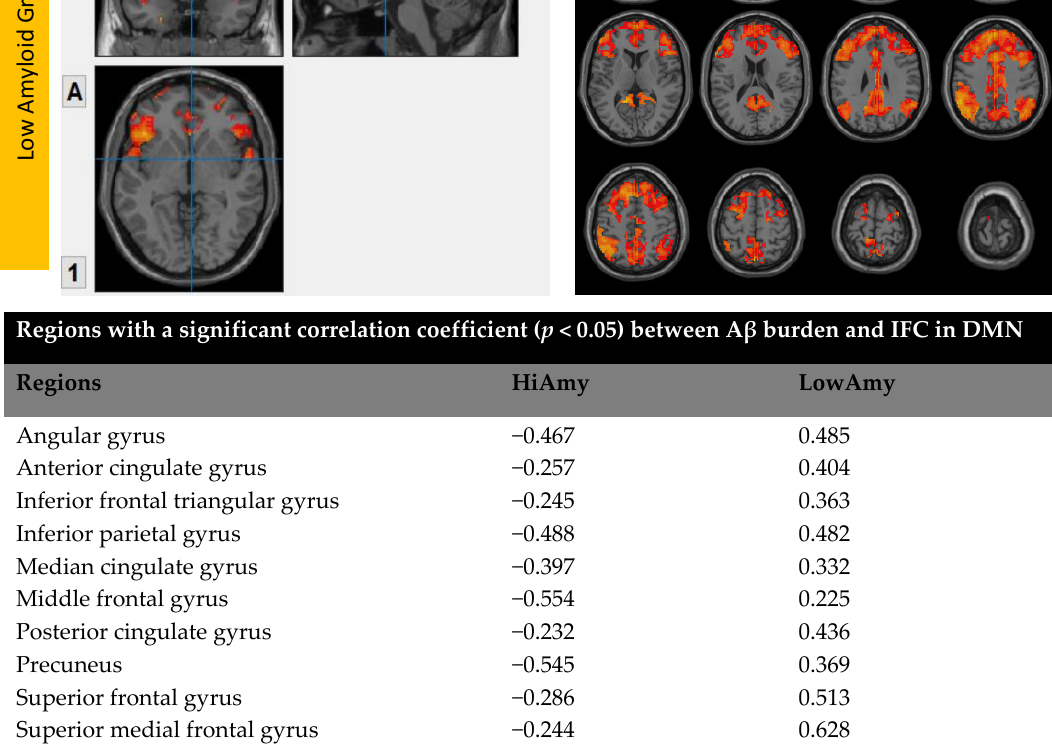
8 of 20 Figure 2. VMHC Maps showing interhemispheric functional connectivity (IFC) of HiAmy and LowAmy groups when compared to HC. ( a) showed Voxel-wise two-sample t-tests of VMHC maps from HiAmy when compared to HC. ( b) showed Voxel-wise two-sample t-tests of VMHC maps from LowAmy when compared to HC. All comparisons were adjusted for age, sex, and total intra- cranial volume, with Gaussian random field correction. The significance threshold at the voxel level was set at p < 0.01; and at cluster level was set at p < 0.05. The blue and red colors illustrate significant